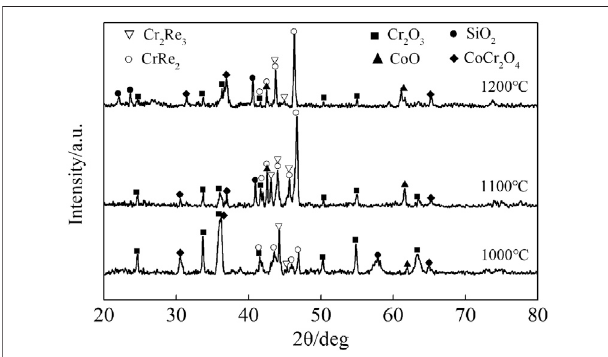
FIGURE 8 | XRD patterns of Co-20Re-25Cr-3Si alloy oxidized under 0.1 MPa laboratory air at 1,000 – 1,200 ° C for 24